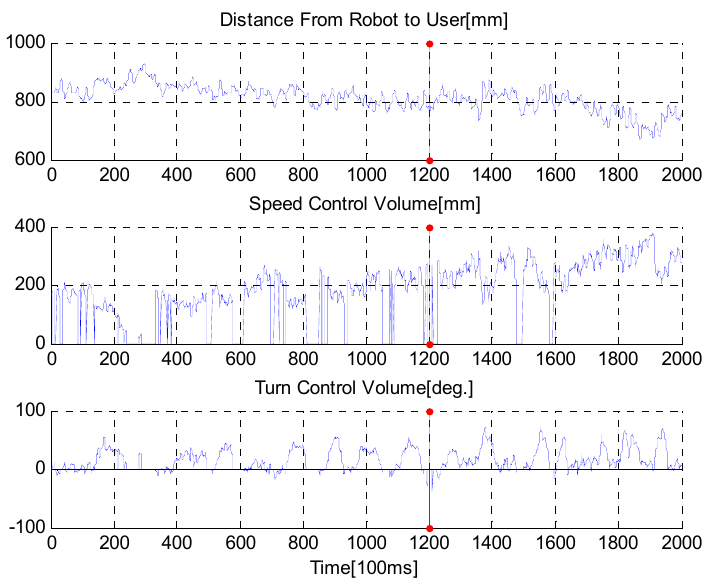
Figure 15. Sensor output acquired from the third